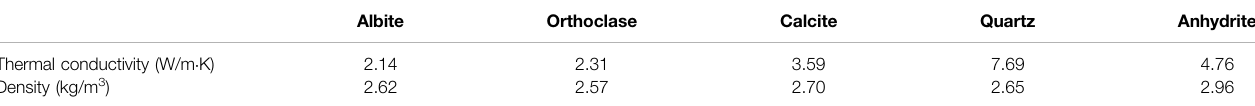
TABLE 1 | Properties of rock-forming minerals.